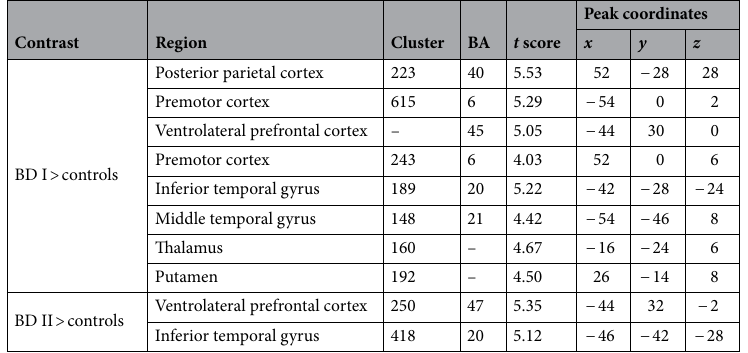
Table 2. Functional connectivity of the left dorsal caudate co-varying with leptin, with between-group differences. Peak coordinates refer to the Montreal Neurological Institute (MNI) space. No higher correlation was found in the healthy controls. Five BD I patients, 2 BD II patients and 12 controls did not undergo plasma leptin level measurement and were excluded from this analysis. BA Brodmann area, BD bipolar disorder. Significance was thresholded at the uncorrected voxel level p = 0.001, followed by the FWE-corrected cluster level p = 0.05.